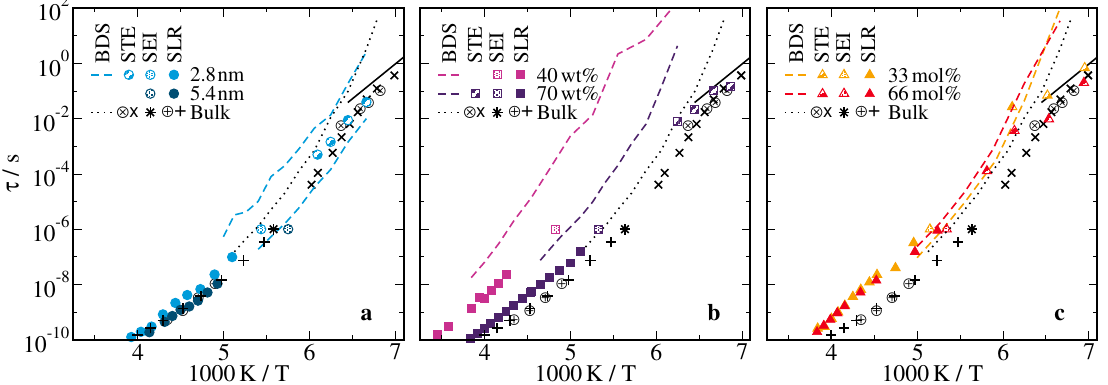
Figure 8. Temperature-dependent correlation times τ n obtained from BDS and 2 H NMR studies on 66mol% D 2 O-DMSO- h 6 solution in ( a ) silica pores with diameters of d = 2.8nm and d = 5.4nm, ( b ) ficoll at solution mass fractions of w s = 70wt% and w s = 40wt%, and ( c ) lysozyme at a solvation level of s = 0.68 g sol / g lys . For the lysozyme matrix, results for a solution with 33mol% water are also shown. For clarity, the displayed BDS results are limited to the I(a/b) processes. In all panels, data for the 66mol% D 2 O-DMSO- h 6 bulk solution are included for comparison, where previous [57] results are shown as circled symbols. The solid lines indicate an Arrhenius temperature dependence with the activation energy E a =